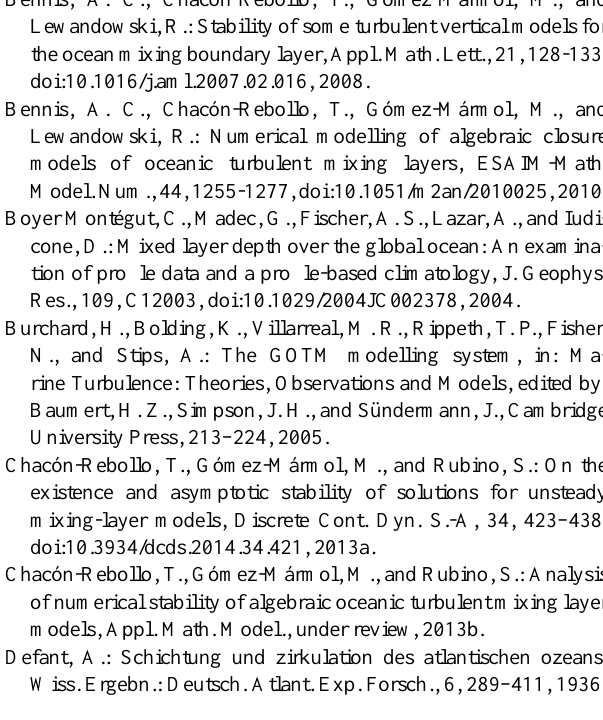
Fig. 12. Test 2: temporal evolution of residual values for model R